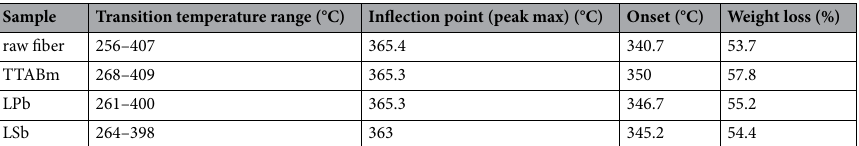
Table 3. Thermogravimetric data relative to the second thermal transition for the raw and TTABm, LPb and LSb samples.